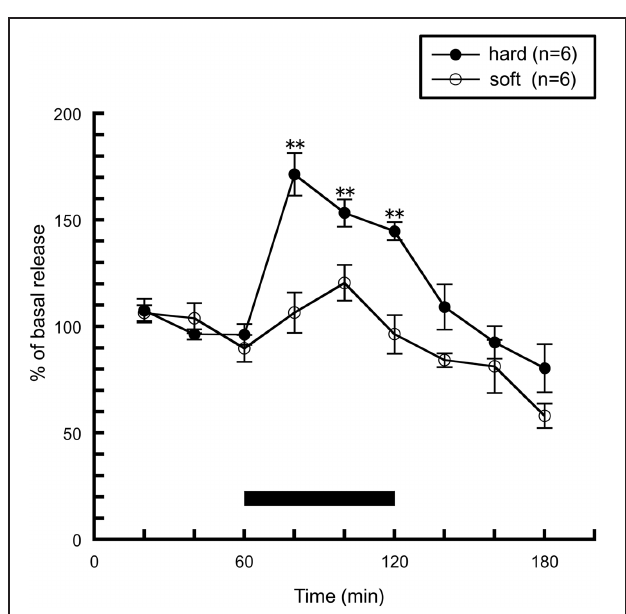
FIGURE 2 | The effects of a 5% D-glucose ( n = 6) or 200mU insulin ( n = 6) injection on (A) blood glucose levels and (B) hypothalamic histamine release in urethane-anesthetized rats. The arrow indicates the time point of injection of each compound. The mean values of